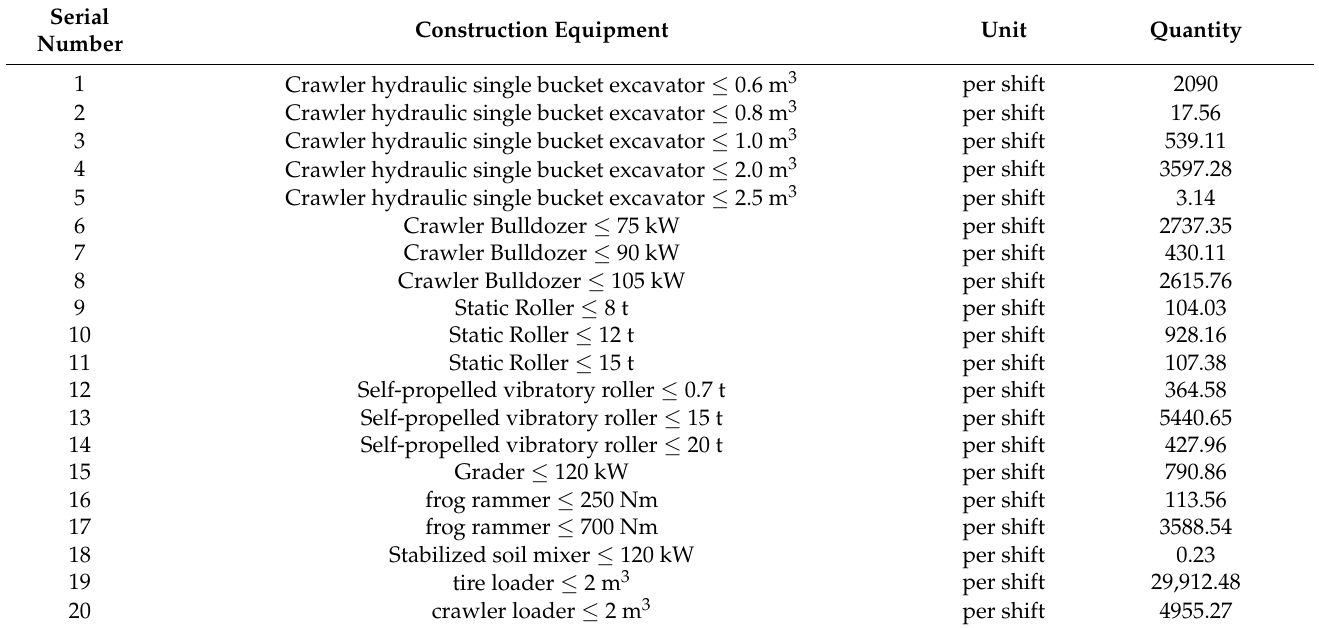
Table 10. Mechanical shift data.